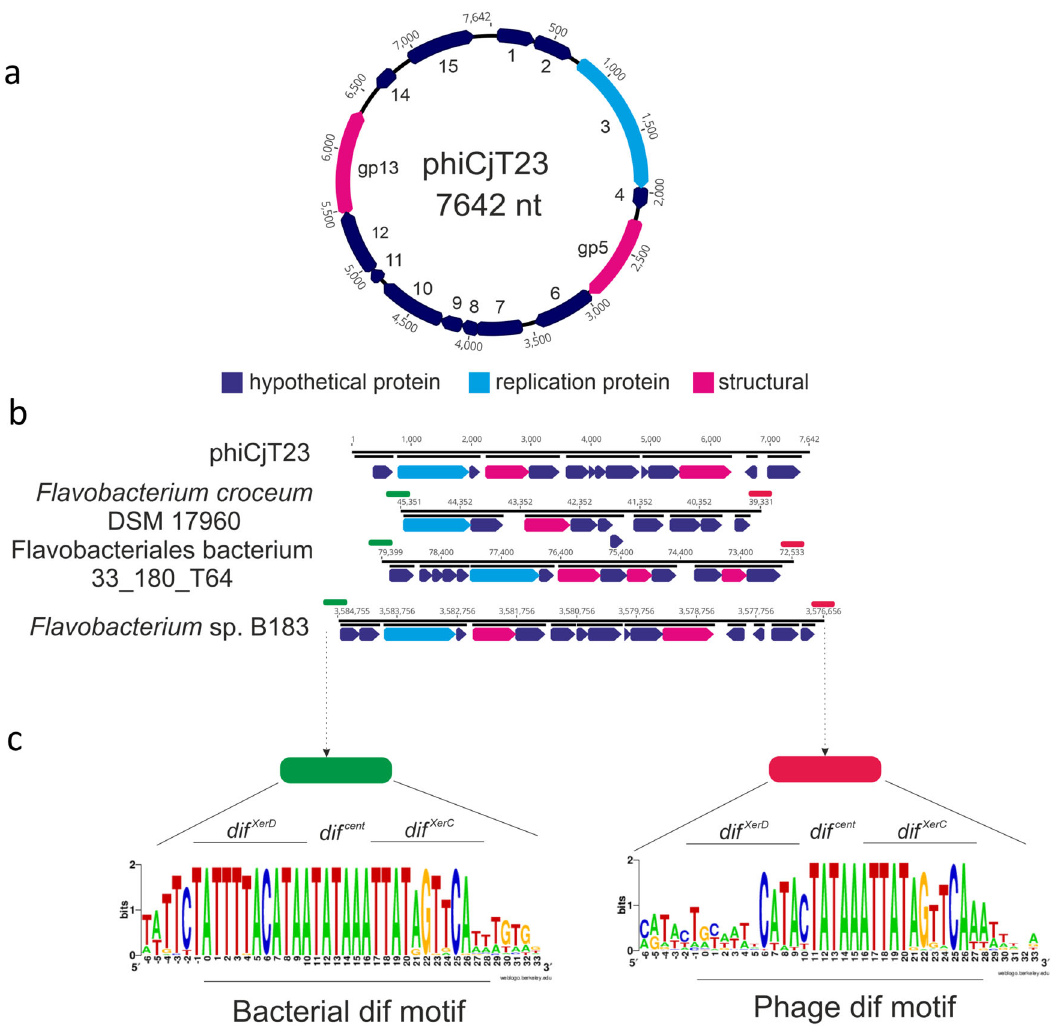
Fig.1|GenomeofatemperatephagephiCjT23andrelatedprophagesfoundin Flavobacterium genomes. a Φ CjT23 genome is a 7642-nt long circular single- stranded DNA molecule with 15 predicted open-reading frames (ORFs). The anno- tated replication initiation protein is indicated in light blue and the two identi fi ed structuralproteins,majorcapsidprotein(MCP,gp5)andspikeprotein(gp13),arein pink. Hypothetical proteins are indicated in dark blue. b Examples of